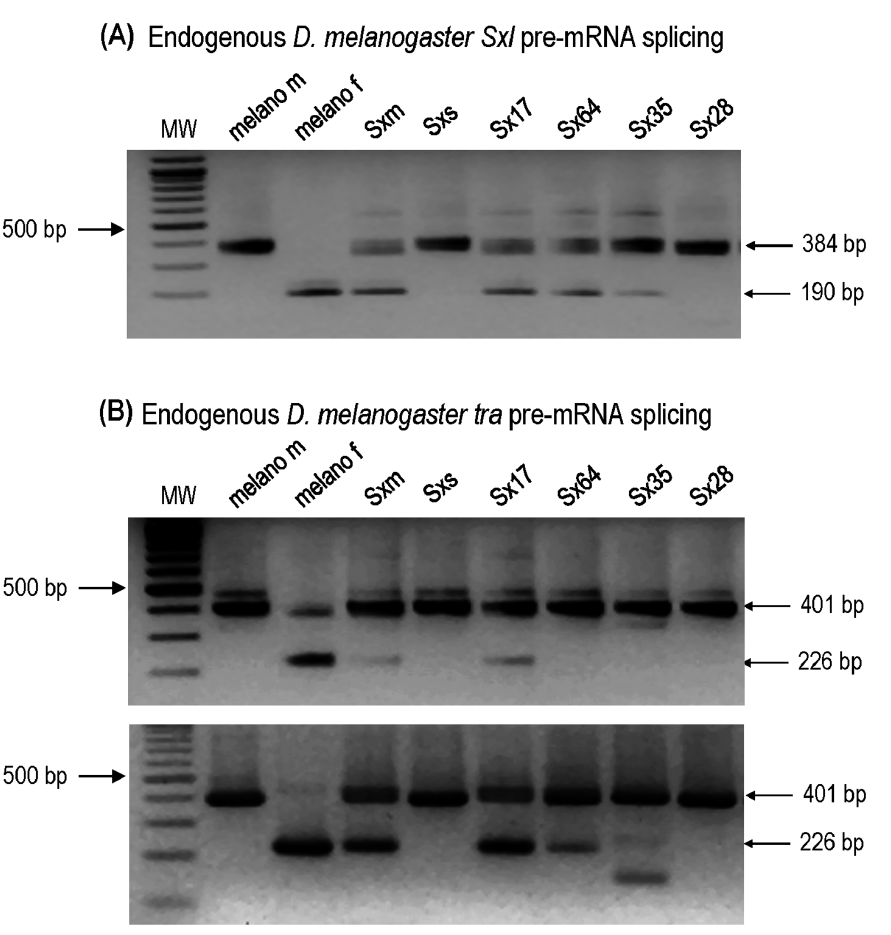
Figure 3. Effect of the SXL proteins on the sex-specific splicing of endogenous Sxl (A) and tra pre-mRNAS (B) in males carrying a null allele of Sxl . The conditions and primers for the RT-PCRs are described in Materials and Methods. The constitution of the SXL proteins is described in the Tables; and ‘‘melano m’’ and ‘‘melano f’’ stand for Drosophila wild type male and female, respectively. The genotypes of the males were: Sxm stands for males ywSxl f1 ct 6 /Y; arm-Gal4,w + / + ; Sxm/Tub-Gal80 ts ; Sxs stands for males ywSxl f1 ct 6 /Y; arm-Gal4,w + / + ; Sxs/Tub-Gal80 ts ; Sx17 stands for males ywSxl f1 ct 6 /Y; arm-Gal4,w + / + ; Sx17/Tub-Gal80 ts ; Sx64 stands for males ywSxl f1 ct 6 /Y; arm-Gal4,w + /Sx64; Tub-Gal80 ts / + ; Sx35 stands for males ywSxl f1 ct 6 /Y; arm-Gal4,w + /Sx35; Tub-Gal80 ts / + ; and Sx28 stands for males ywSxl f1 ct 6 /Y; arm-Gal4,w + /Sx28; Tub-Gal80 ts / + . These males were produced by crossing females ywSxl f1 ct 6 /Y; arm-Gal4,w + /CyO,Cy; Tub-Gal80 ts /MKRS,Sb with males yw/Y; Sxm/MKRS,Sb ; males yw/Y; Sxs/MKRS,Sb ; males yw/Y; Sx17/MKRS,Sb ; males yw/Y; Sx64/CyO,Cy ; males yw/Y; Sx35/CyO,Cy ; and males yw/Y; Sx28/CyO,Cy